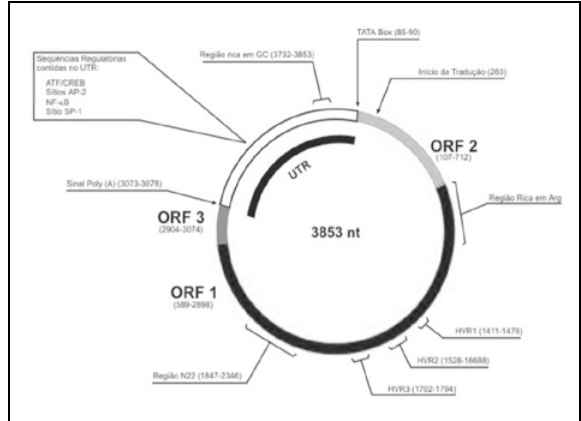
Figura – Organização genômica do TTV mostrando o DNA circular, fita simples, de polaridade negativa, encapsulado dentro do vírion. Posições nucleotídicas do isolado TA278. O esquema mostra as ORFs 1, 2 e 3, a região UTR, bem como outras regiões importantes. É o caso da região N22, muito utilizada para estudos